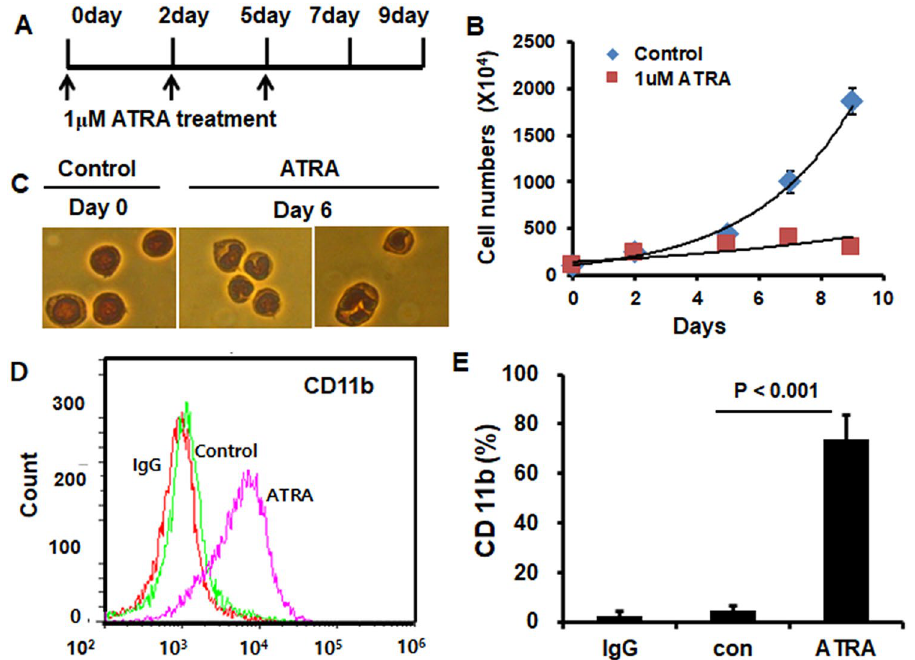
Figure 3. HL-60 cells differentiated to neutrophil-like cells by all–trans-retinoic acid (ATRA). ( A , B ) Growth curve. HL60 cells (5 × 10 5 /mL) were seeded into a T-75 flask and treated with 0 or 1 μM ATRA once every 2 to 3 days for 5 days. Cells not stained by trypan blue were counted for 9 days. ( C ) Nuclear morphology of HL60 cells. HL60 cells were treated with 0 or 1 μM ATRA for 6 days and stained with Wright-Giemsa. At day 0, the nuclear morphology of dHL60 cells was ovate (left) but showed a dent (center) or lobular shape at 6 days (right) (magnification, ×400). ( D , E ) FACS analysis of CD11b expression in dHL60 cells. HL60 cells were differentiated by 0 or 1 μM ATRA for 6 days and stained with an anti-CD11b-FITC antibody. IgG was used as the negative control. Expression of CD11b (left). Percentage of total cells expressing CD11b (right). Independent sample t-test was used to find the